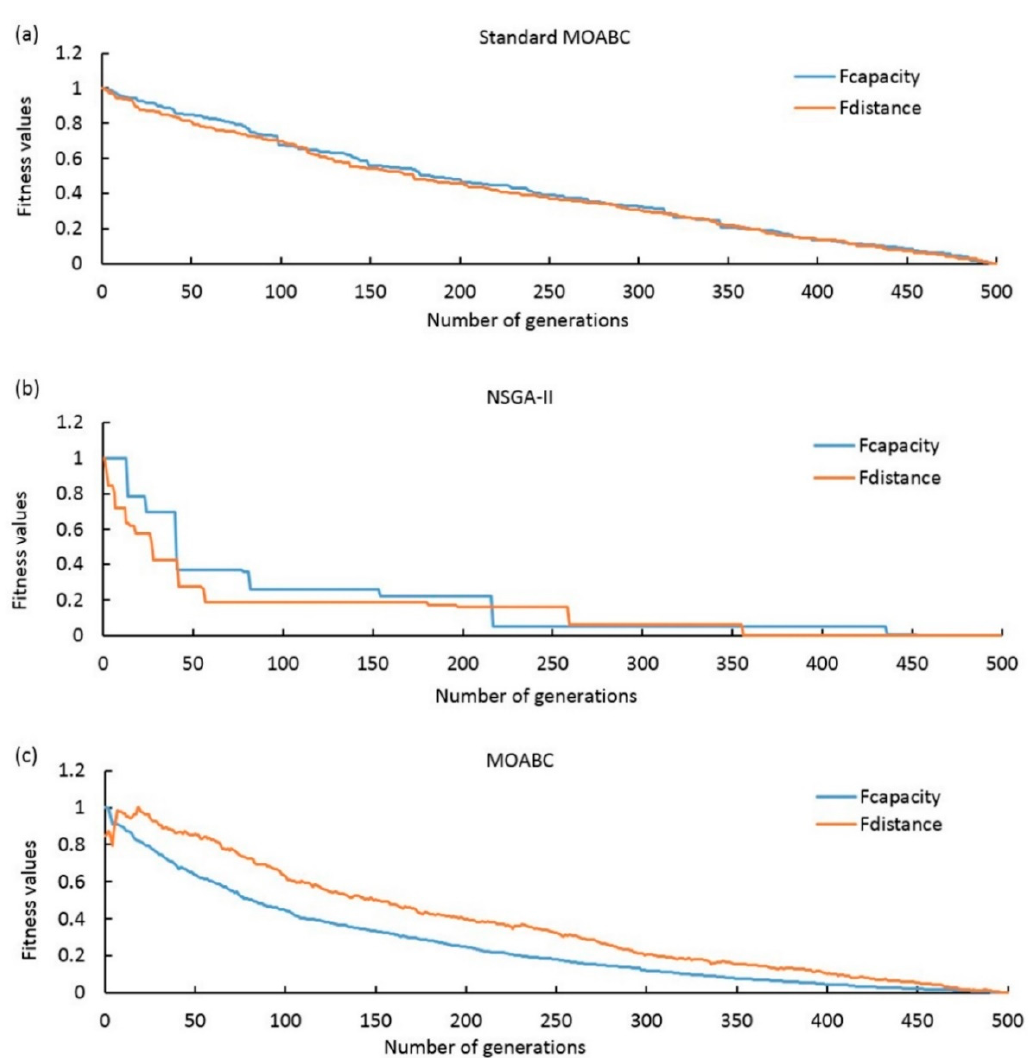
Figure 14. The convergence process for different generations of ( a ) standard MOABC; ( b ) NSGA-II; and ( c ) the proposed MOABC.